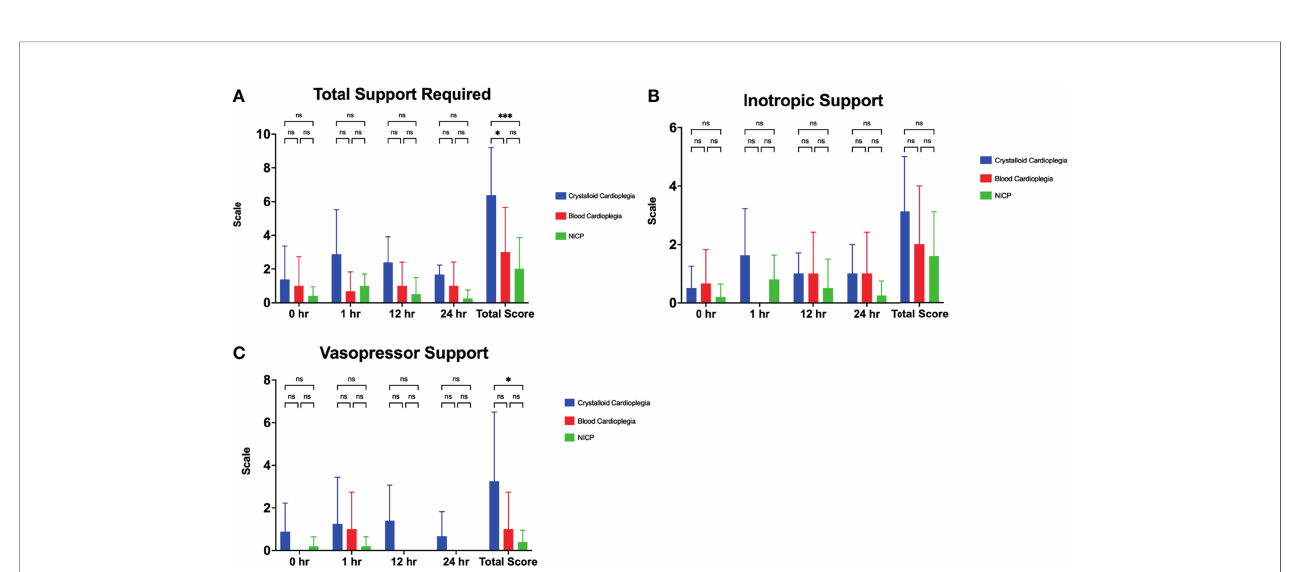
FIGURE 2 | (A) Total support required in the fi rst 24 hours after transplantation in crystalloid cardioplegia, blood cardioplegia and NICP groups, based on objective quanti fi cation from Table 1 . (B, C) Inotropic and vasopressor scores in the fi rst 24 hours after transplantation between groups. Total scores were calculated as the summation of all scores for each time point. *p=<0.05, **p<0.005, ***p<0.0005. ns, not signi fi